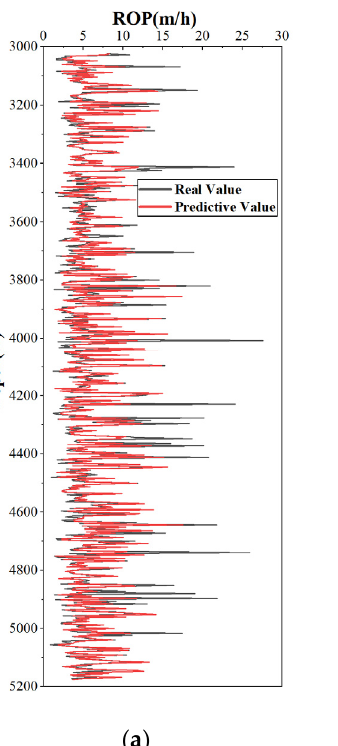
Appl. Sci. 2022 , 12 , x FOR PEER REVIEW 11 of 14 Figure 7. ROP prediction results on test set 1: ( a ) ROP prediction results of FNN model; ( b ) ROP prediction results of LSTM model; ( c ) ROP prediction results of LSTM-FNN model.